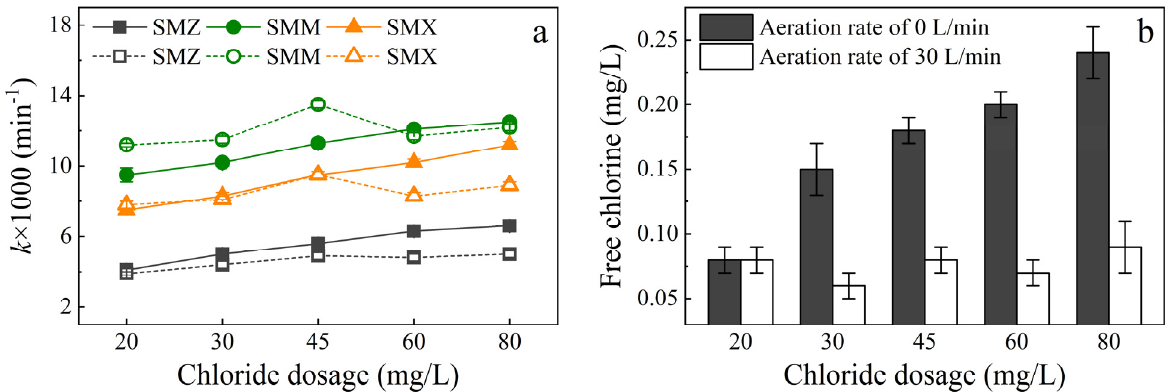
Figure 2. Effect of Cl − concentration on sulfonamide degradation. Conditions: Cl − concentration from 20 to 80 mg/L, aeration rate of 0 or 30 L/min, UV power of 48 W, current of 1.0 A (2.7 mA/cm 2 ), and initial pH of 8.3. ( a ) The k value for sulfonamide degradation at different Cl − concentrations. Solid points represent an aeration rate of 0 L/min and empty points represent an aeration rate of 30 L/min. ( b ) The free chlorine concentration at 120 min for different Cl − concentrations.